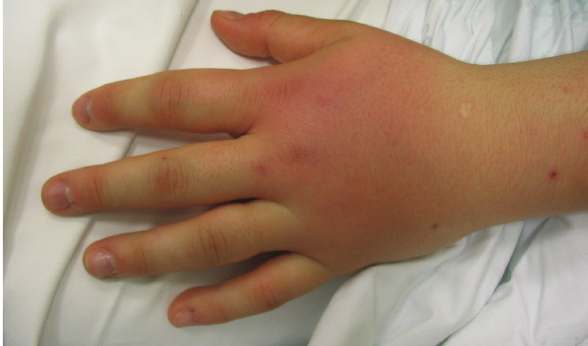
Figure 3: Metacarpal-phalangeal arthritis of the left